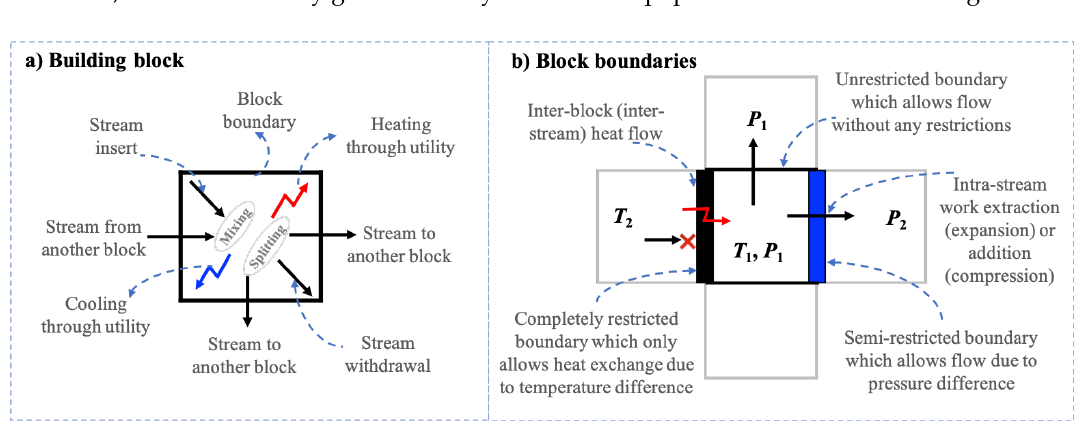
Figure 1. Elements of abstract building blocks: ( a ) block interior ( b ) block